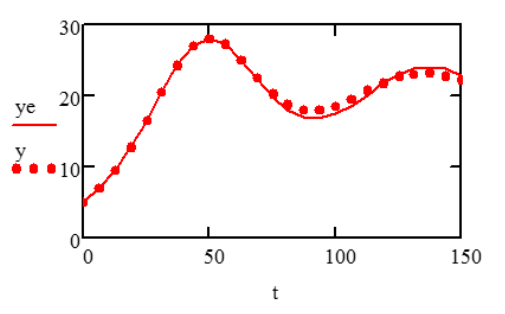
Fig. 4. Graph of original solution y = y ( t ) (dots) and solution with estimated parameters (solid